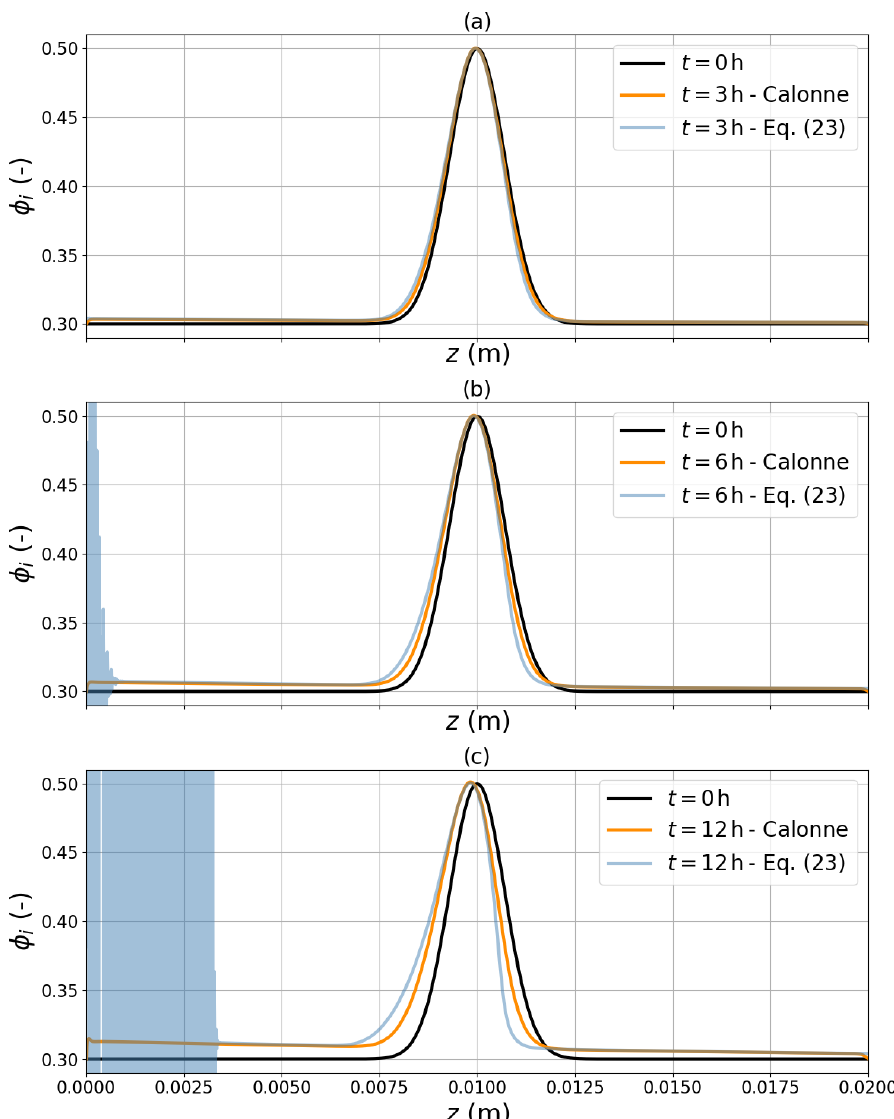
Figure 4. Comparison between Calonne’s model coupled to an evolving ice phase and the derived advection Eq. (23) for an initial Gaussian